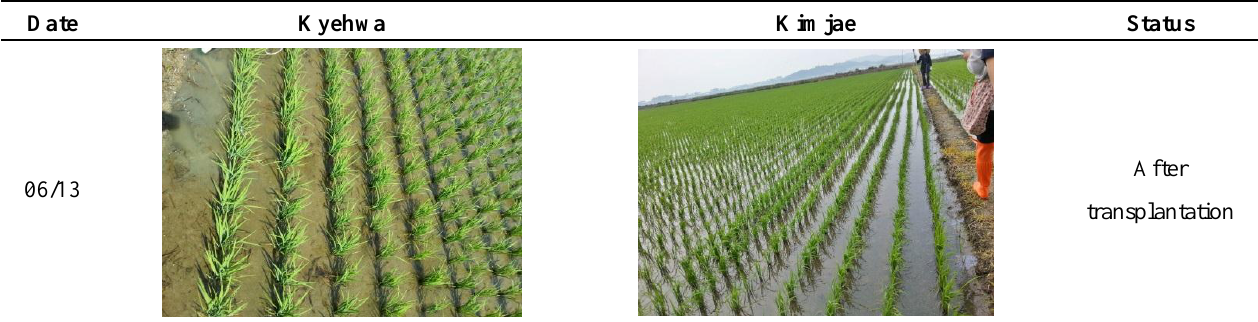
Table 2. Time-series photographs of paddy rice in the Kyehwa and Kimjae areas.